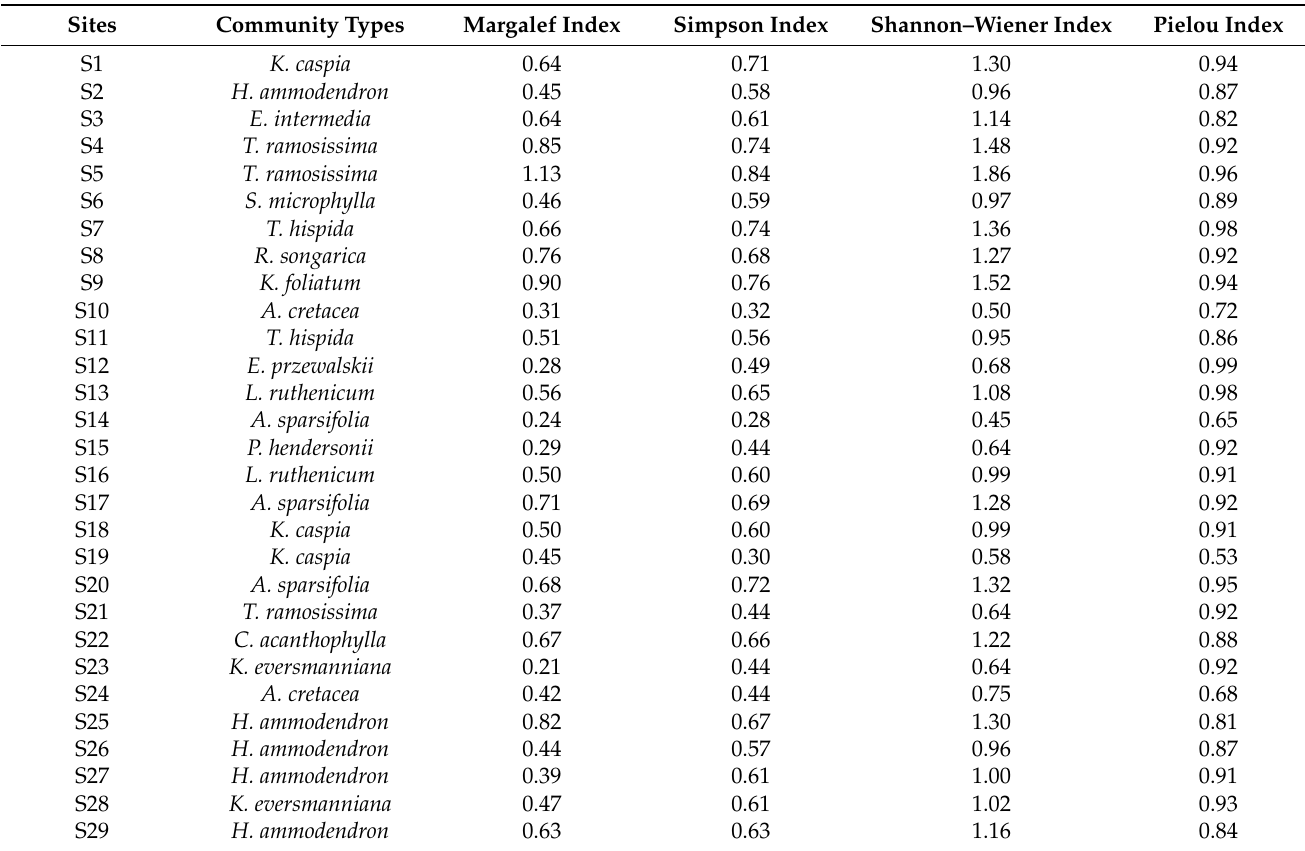
Table 4. Diversity index in different plant